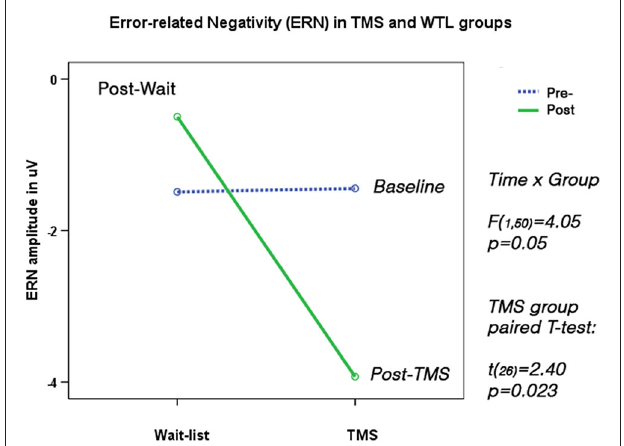
FIGURE 6 | Error-related Negativity (ERN, 40–120 ms post-error) shows Time X Group interaction ( F = 4.05, p = 0.05). Post-TMS ERN amplitude became significantly more negative ( t = 2.40, p = 0.023). N = 26/per group, as 2 subjects out of 54 committed no commission errors on the second